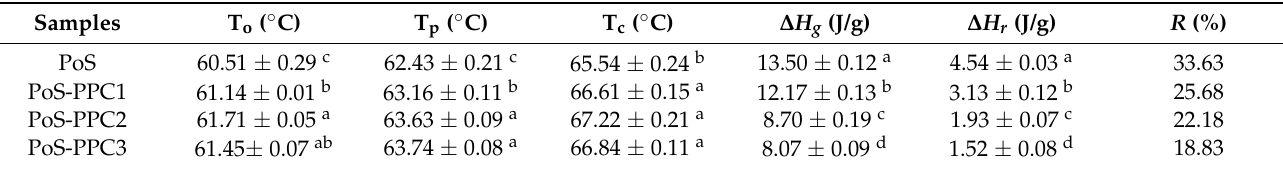
Table 3. Thermal properties of PoS and PoS-PPC